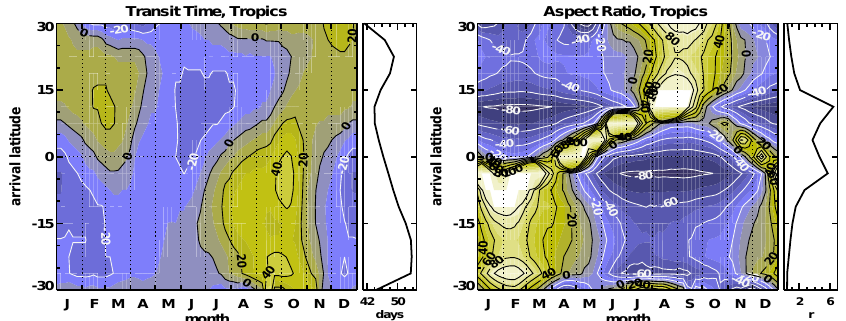
Fig. 8. Same as Fig. 7 but for southern hemispheric extratropics.